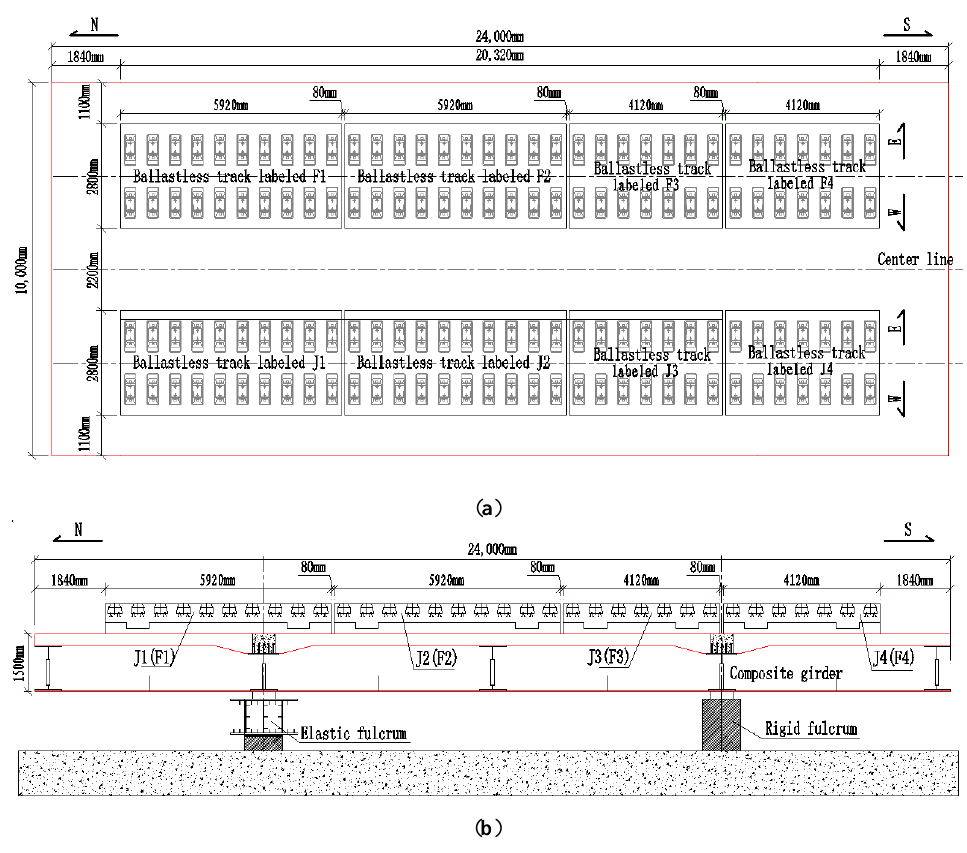
Figure 2. Full-scale unit-plate ballastless track used in this work. ( a ) Top view of the model; ( b ) side view of the model .